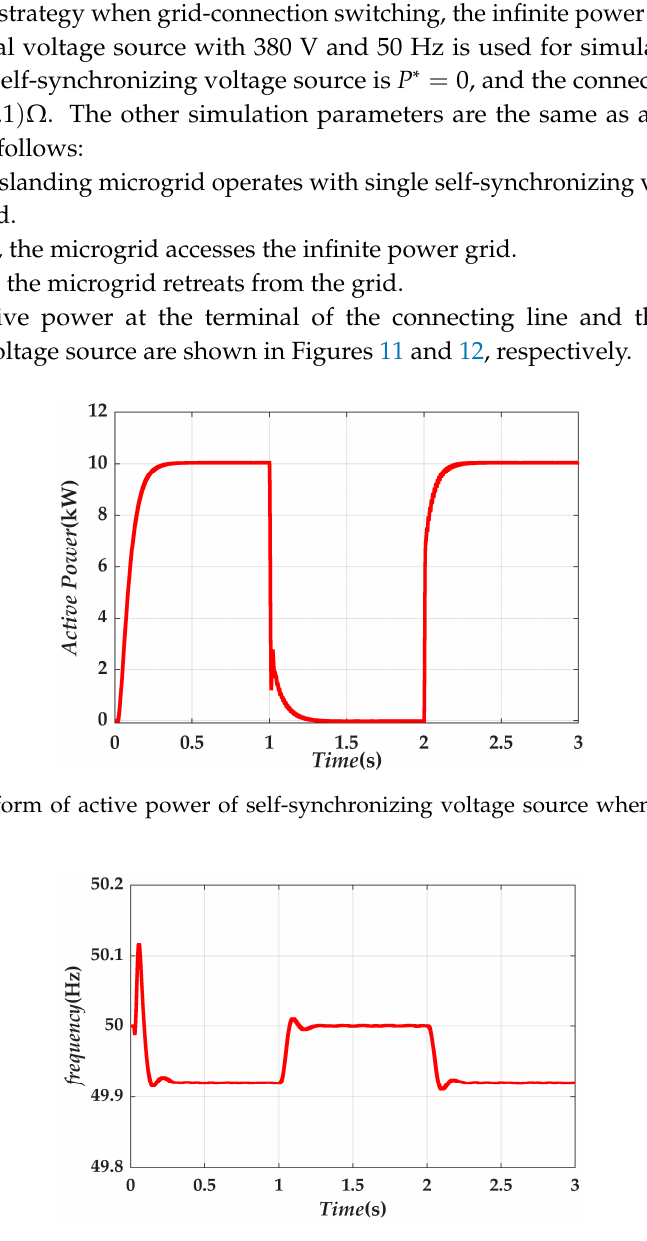
Figure 12. Waveform of frequency of self-synchronizing voltage source when grid-connection switching.